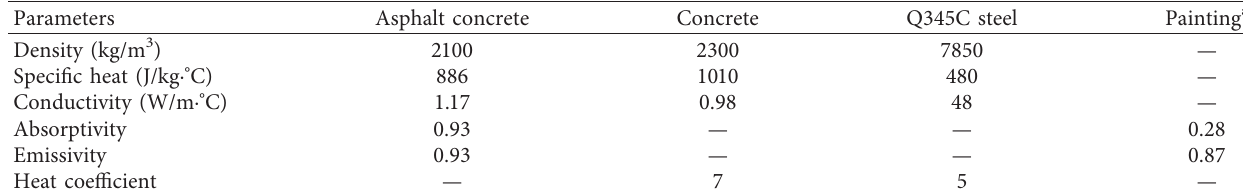
Table 1: Thermophysical parameters of the materials.